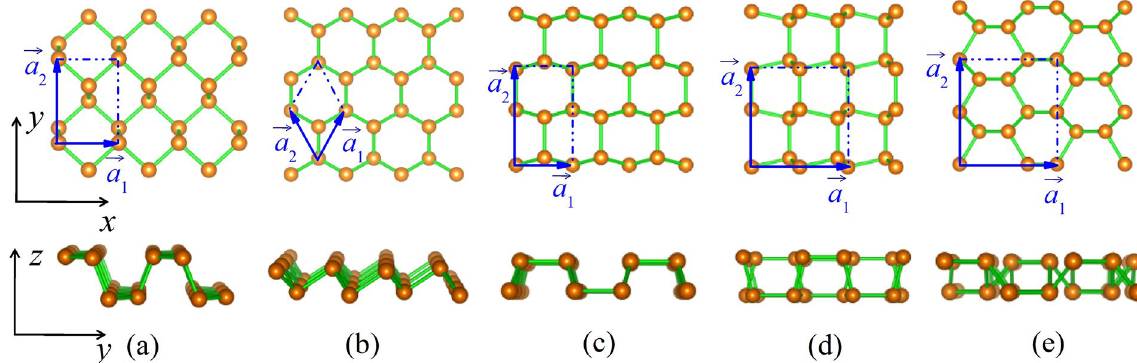
Figure 1. Top- and side-views of ( a ) α -phosphorene, ( b ) β -phosphorene, ( c ) γ -phosphorene, ( d ) δ -phosphorene, and ( e ) ζ -phosphorene. The coordinate axes ( x , y , z ) and lattice vectors ( → a